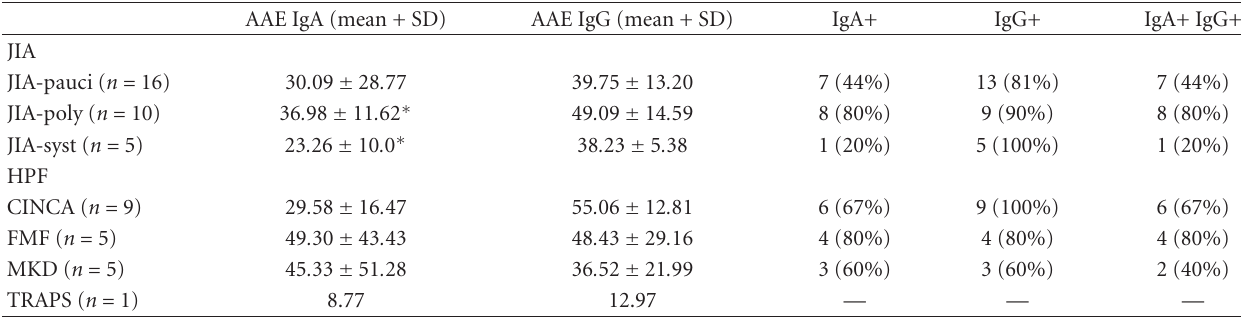
Table 3: Serum level and percentage of AAE IgA+ and AAE IgG+ in JIA stratified for clinical presentation and in HPF classified for genetic defect. Levels of anti- α -enolase IgA and IgG in patients with pauciarticular, polyarticular, or systemic juvenile idiopathic arthritis (JIA) CINCA syndrome, FMF, MKD, and TRAPS hereditary periodic fevers (HPF) were reported as mean and standard deviation (SD). Results are expressed as arbitrary units per mL (AU/mL). Patients’ AAE levels are compared by t -test ( ∗ = P < 0.05). Percentage of AAE IgA and IgG positivity in each disease class is also